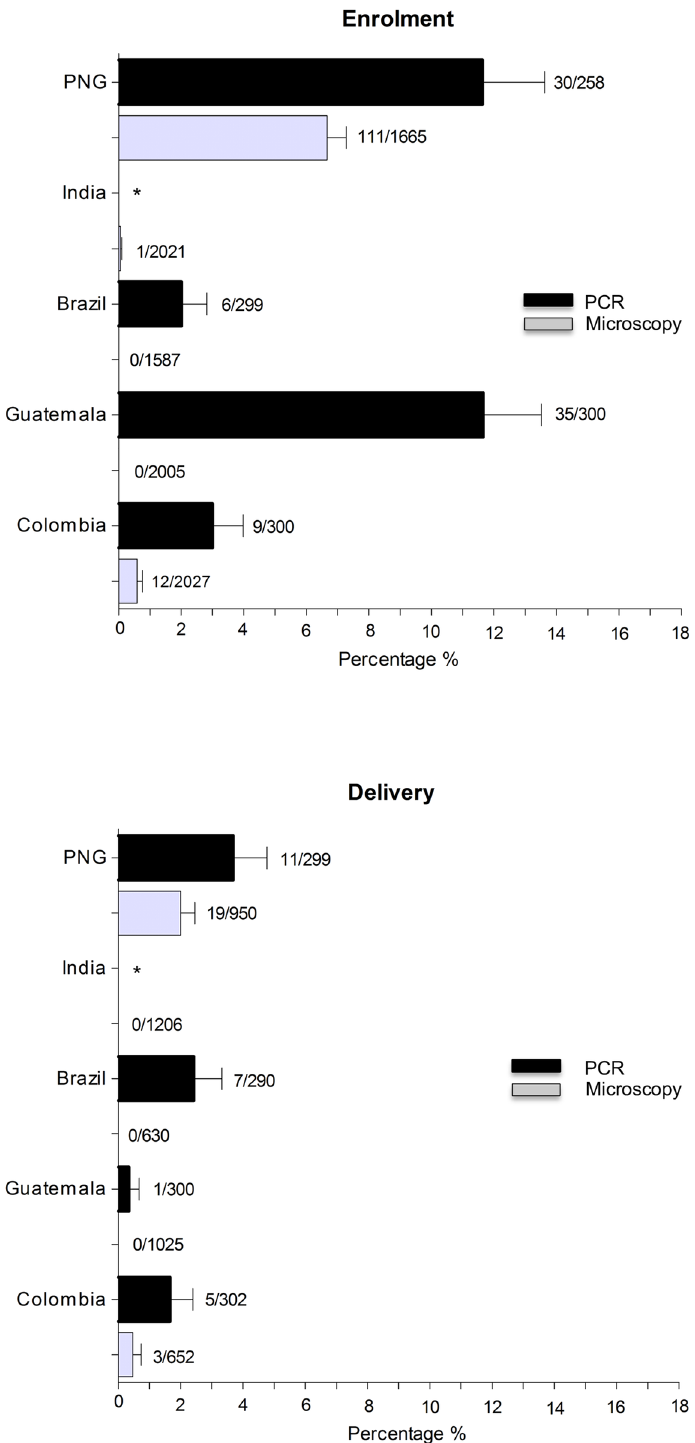
Fig 3. Prevalence of P . falciparum infection. * Not available data. Technicalproblemsin the performance of the molecularanalyses(PCR) for P . falciparum occurred at the reference laboratoryin India. No biological specimens remainedavailable after that sufficient to repeat the analysesin an